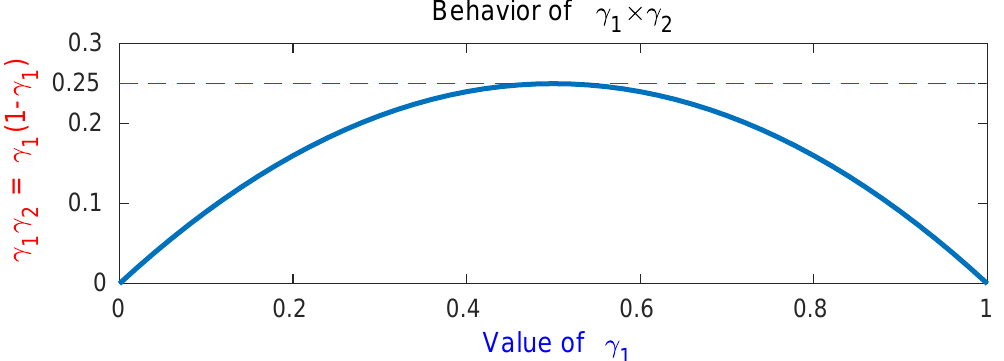
Figure 4. γ 1 γ 2 value with respect to γ 1 . This value is close to zero when one source is dominant, and has a maximum value of 0.25 when two sources are evenly mixed.